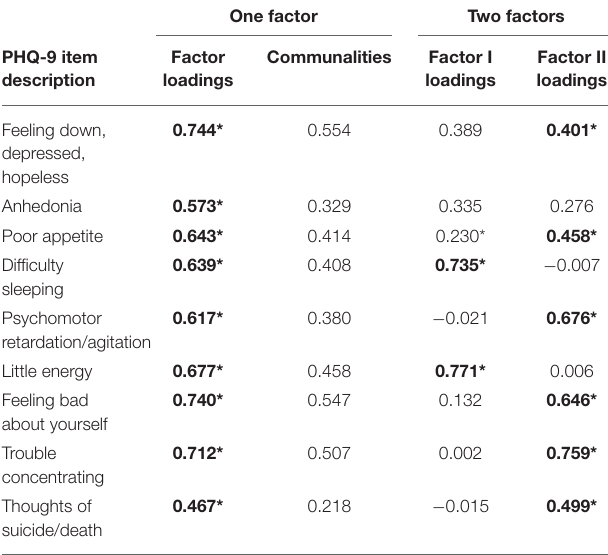
TABLE 2 | Results of exploratory factor analysis.